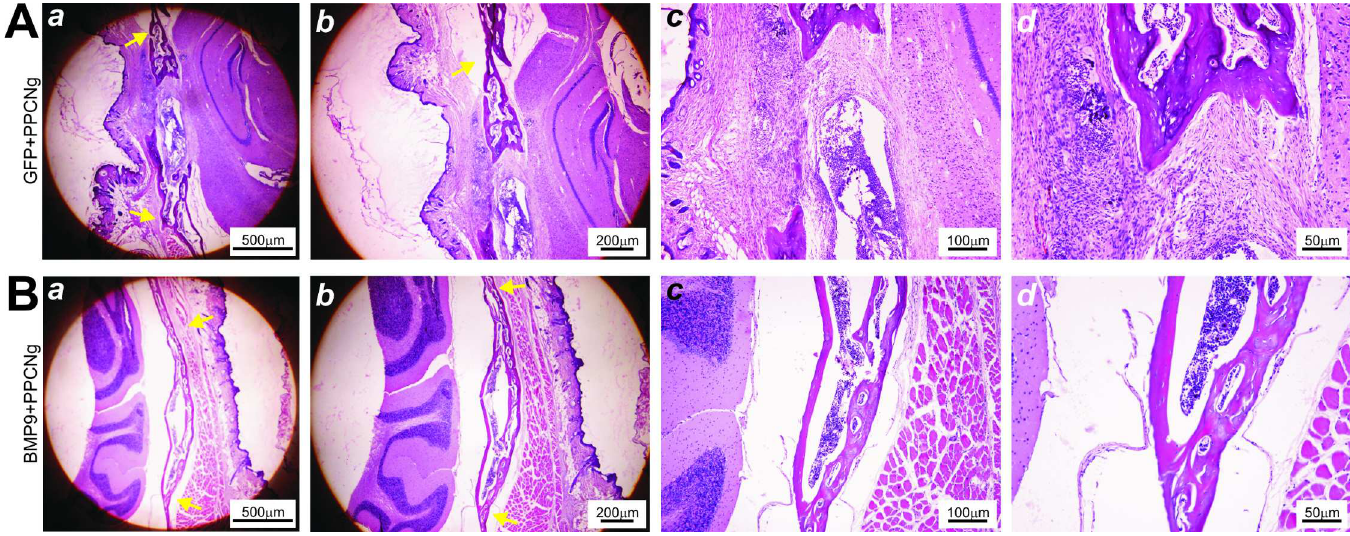
Fig 4. Histologic evaluation of the BMP9-induced calvarial defect repair. Histologicanalysisof tissue microsectionsharvested12 weeks post-treatment. Yellow arrows indicate the originaldefect borders. (A) The defect site of this AdGFP-treated mouse shows incompletehealing;there is some ingrowth of bone, but fibrous tissue fills part of the defect. (B) Conversely, the defect site of an AdBMP9-treated mouse has been completelybridgedwith new bone. All sections show no trace of PPCN material, indicating